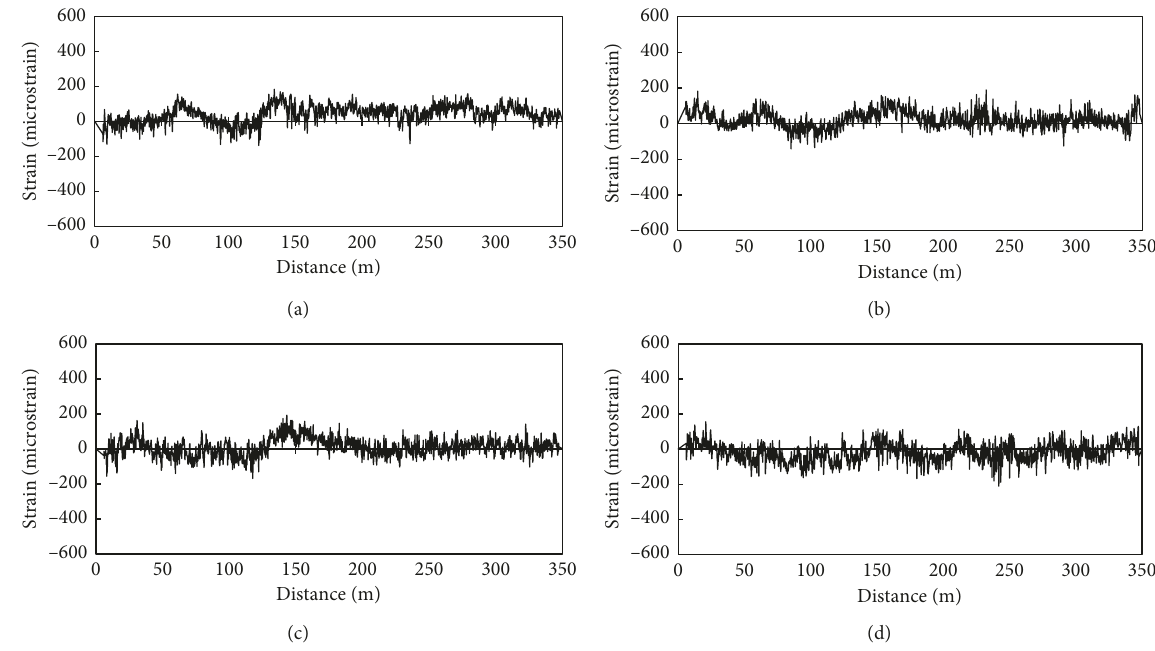
Figure 6: Strain diagrams of lines 1–4 in the early stage of the scaffolding removal. (a) Line 1. (b) Line 2. (c) Line 3. (d) Line